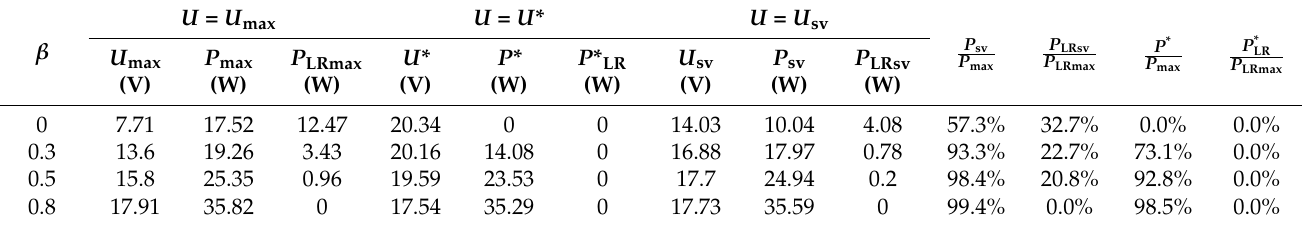
Table 2. PV module output data at U max , U *, U mid under different β